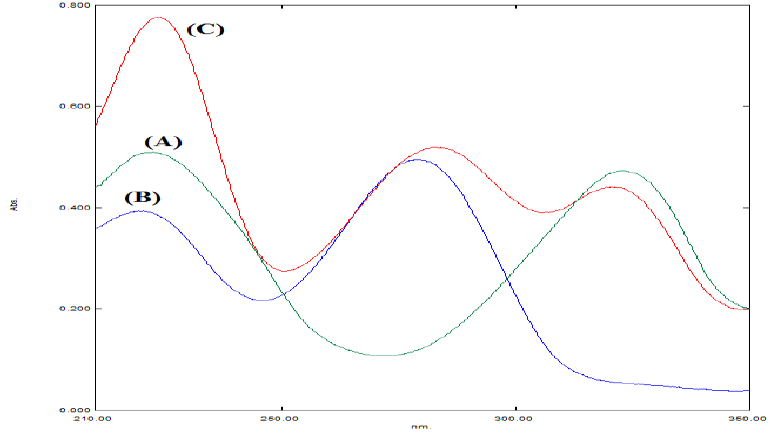
Figure 2. Absorption spectra of (A) 10 µg mL-1 FAV, (B) 10 µg mL-1 MLP, and (C) their mixture.